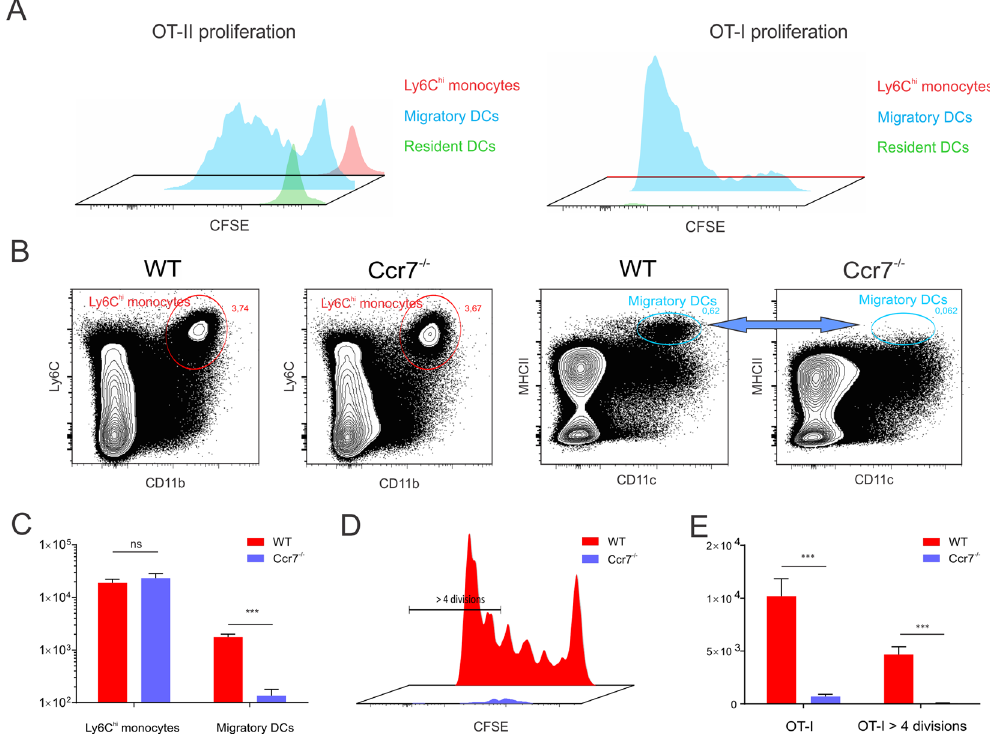
Figure 5. Migratory DCs constitute the major antigen presenting population to CpG adjuvanted protein vaccination. ( A ) Proliferation of CFSE labelled OT-I and OT-II cells following incubation with respectively Ly6C hi monocytes, migratory DCs and resident DCs sorted from the pooled draining lymph nodes of 30 mice injected with OVA/CpG. (n = 5; mean + / − SD). Data shown are representative of two independent sorting experiments. ( B – C ) Flow cytometric comparison of Ly6C hi monocyte and migratory DC influx in the draining lymph nodes of CpG injected WT and Ccr7 − / − mice. ( B ) Contour plots showing Ly6C hi monocyte and migratory DC frequencies.( C ) Graph showing the absolute numbers of Ly6C hi monocytes and migratory DCs (n = 5; mean + / − SD). ( D – E ) Flow cytometric analysis of OT-I proliferation in the draining lymph nodes of WT and Ccr7 − / − mice immunized four days earlier with OVA/CpG. ( D ) Histogram overlay of OT-I proliferation in WT and Ccr7 − / − mice. ( E ) Graph quantifying the total numbers of OT-I cells and the number of OT-I cells having undergone over 4 divisions (n = 5; mean + / − SD). Data are representative of three independent